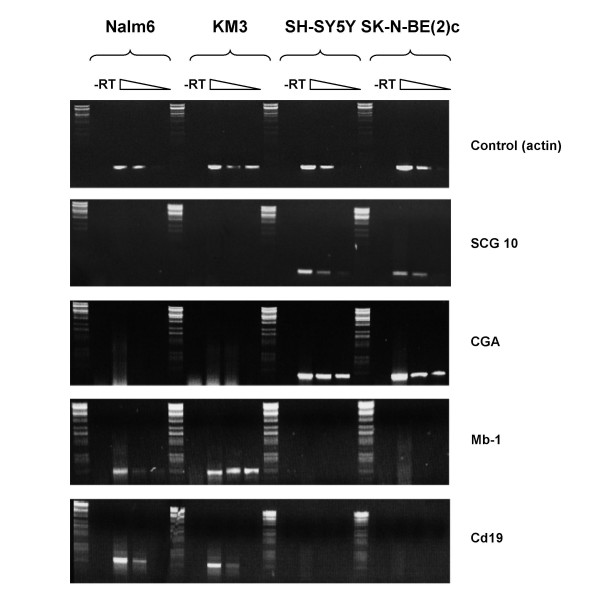
EBF target genes are expressed in a tissue specific manner. The figure show ethidium bromide stained agarose gels with the products from RT-PCR analysis of Nalm6, KM3, SH-SY5Y and SK-N-BE(2)c cells. The panel shows the expression of actin, SCG 10, CGA, mb-1 and CD19 mRNA as indicated. Serial dilutions using 1, 1/5 and 1/25 of the template cDNA after 25 (actin) and 30 (SCG 10, CGA, mb-1 and CD19) cycles of PCR were used.